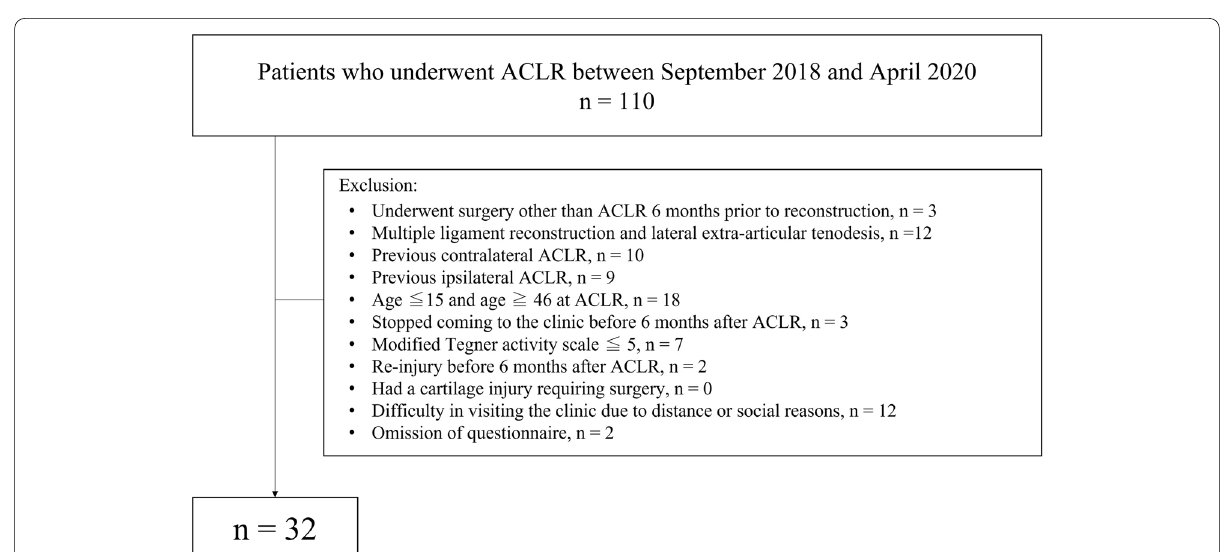
Fig. 1 Flow chart of participant enrollment. ACLR, anterior cruciate ligament reconstruction